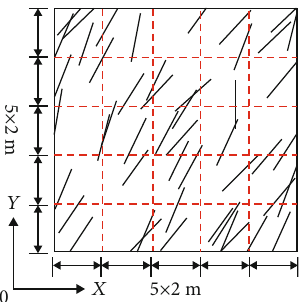
Figure 2: Equal-partition sampling method.